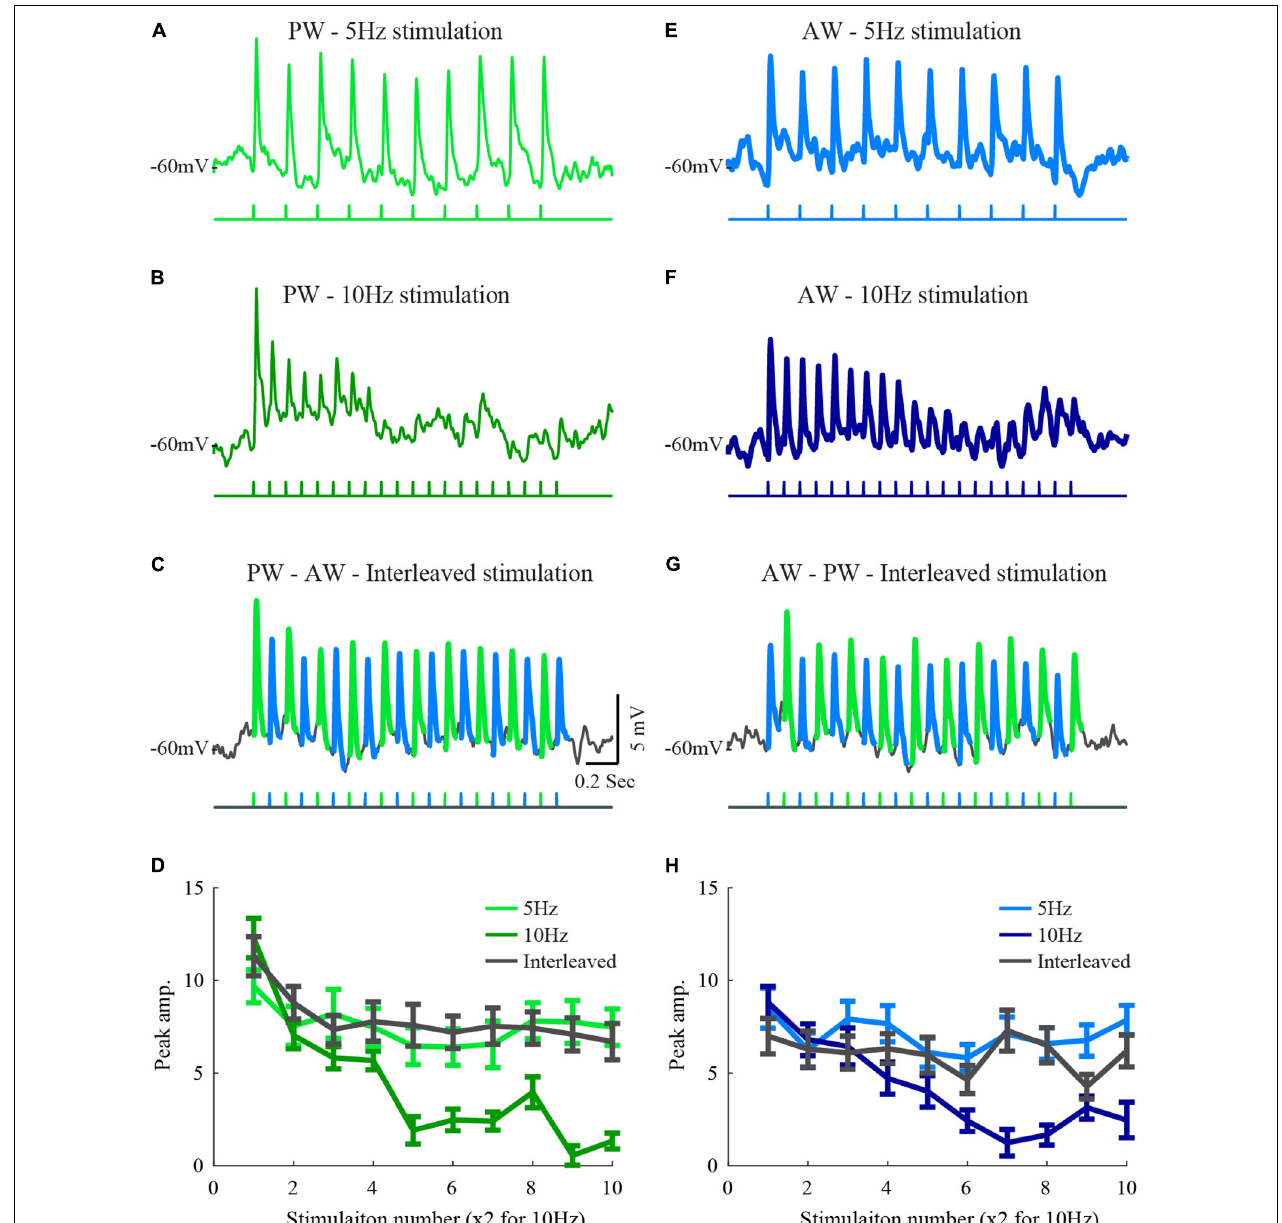
FIGURE 1 | Responses of a layer 2/3 cell to stimulation of two whiskers during interleaved stimulation. (A) The average response of a layer 2/3 cell to 5 Hz stimulation of the principal whisker (stimulation pattern is depicted below the trace). (B) The average response of the same cell to 10 Hz stimulation of the PW principal whisker. (C) The average response to stimulation of the principal whisker and to the adjacent whisker under interleaved stimulation (the trace was segmented by colors to depict the response to the two stimulated whiskers. (D) The average peak amplitudes of the three stimulation patterns in (A–C) are depicted in light-blue for the 5 Hz stimulation, blue for the 10 Hz, and in dark gray for the response to the principal whisker during the interleaved stimulation. (D–H) Same conventions as in (A–D) for responses to the adjacent whisker. The scales are similar for all